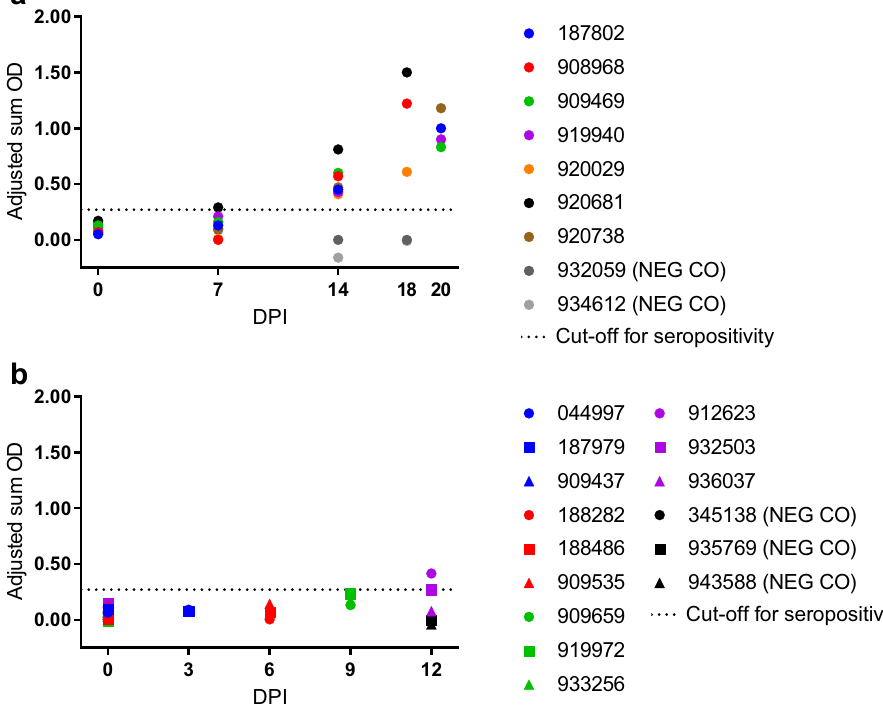
Figure 3. Anti-Kasokero virus (KASV) IgG responses. Anti-KASV IgG responses in ( a ) serially-sampled and ( b ) serially-euthanized, KASV-inoculated and negative control (NEG CO) bats according to days post inoculation